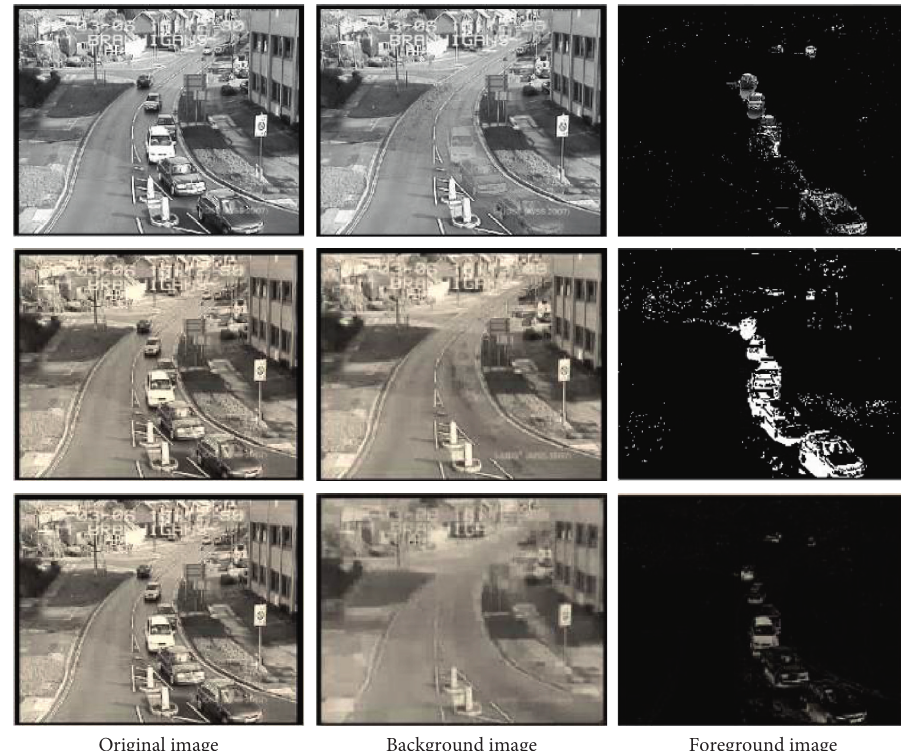
Figure 7: Detection results in a simple intersection